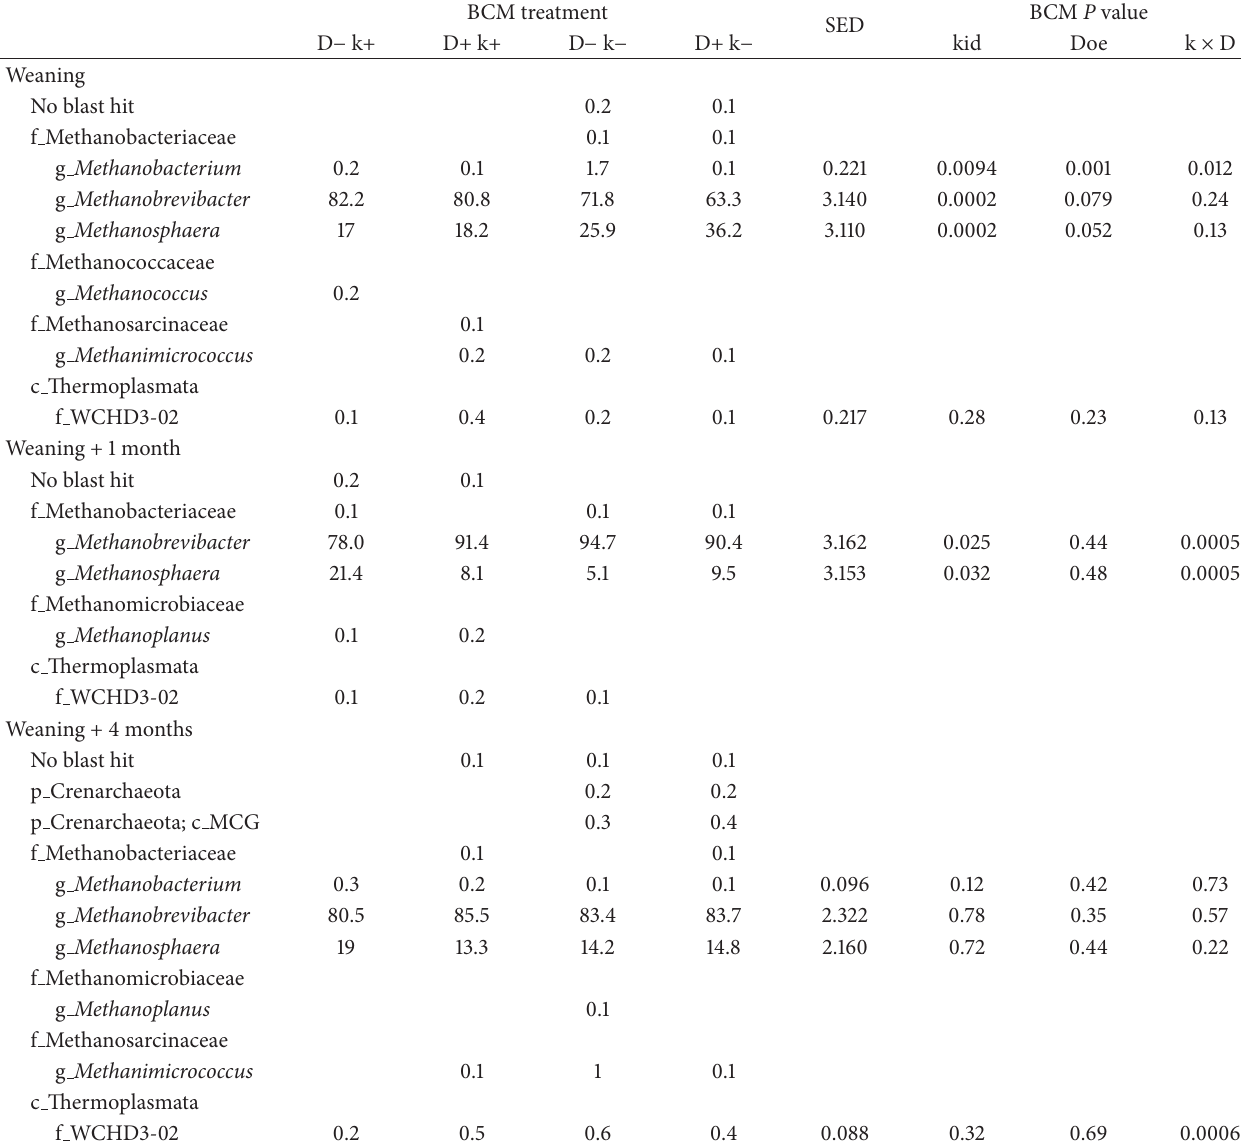
Table 2: Effect of bromochloromethane (BCM) treatment of does and kids on relative abundance (% of total sequences) at weaning, 1 month, and 4 months later in the rumen of